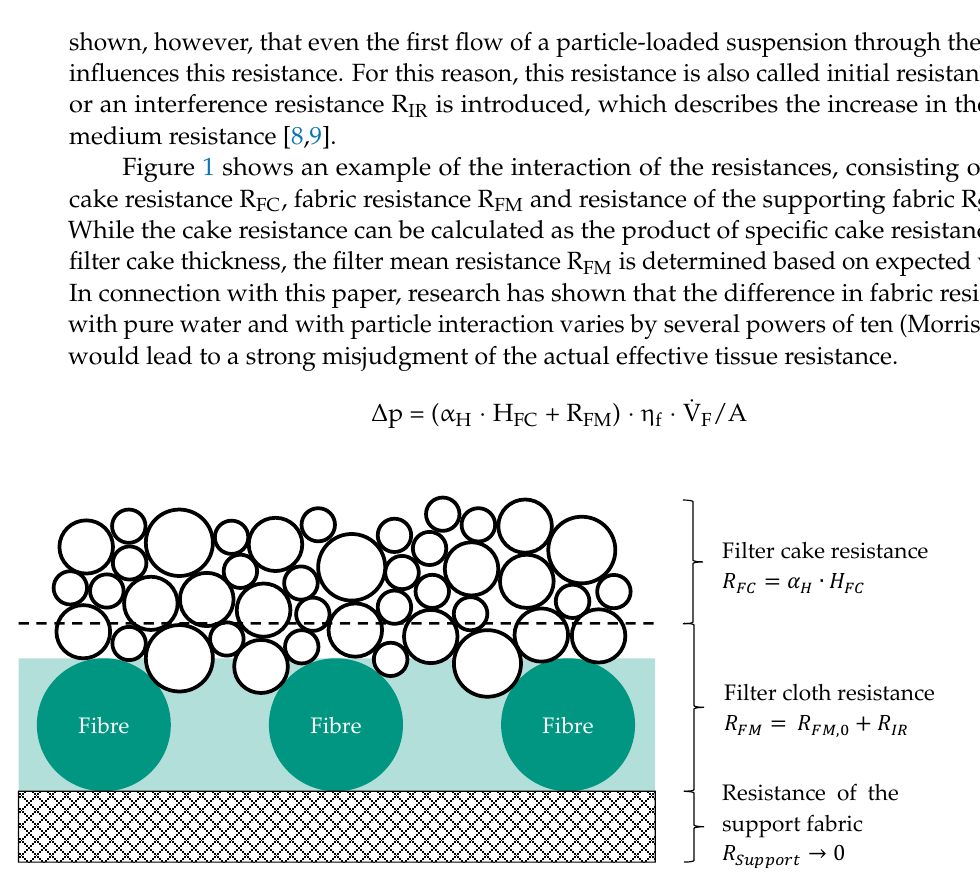
Figure 1. Schematic representation of the effective resistances in the cross-section of a filter cake (R FC ), including filter (R FM ) and support fabric (R support ).